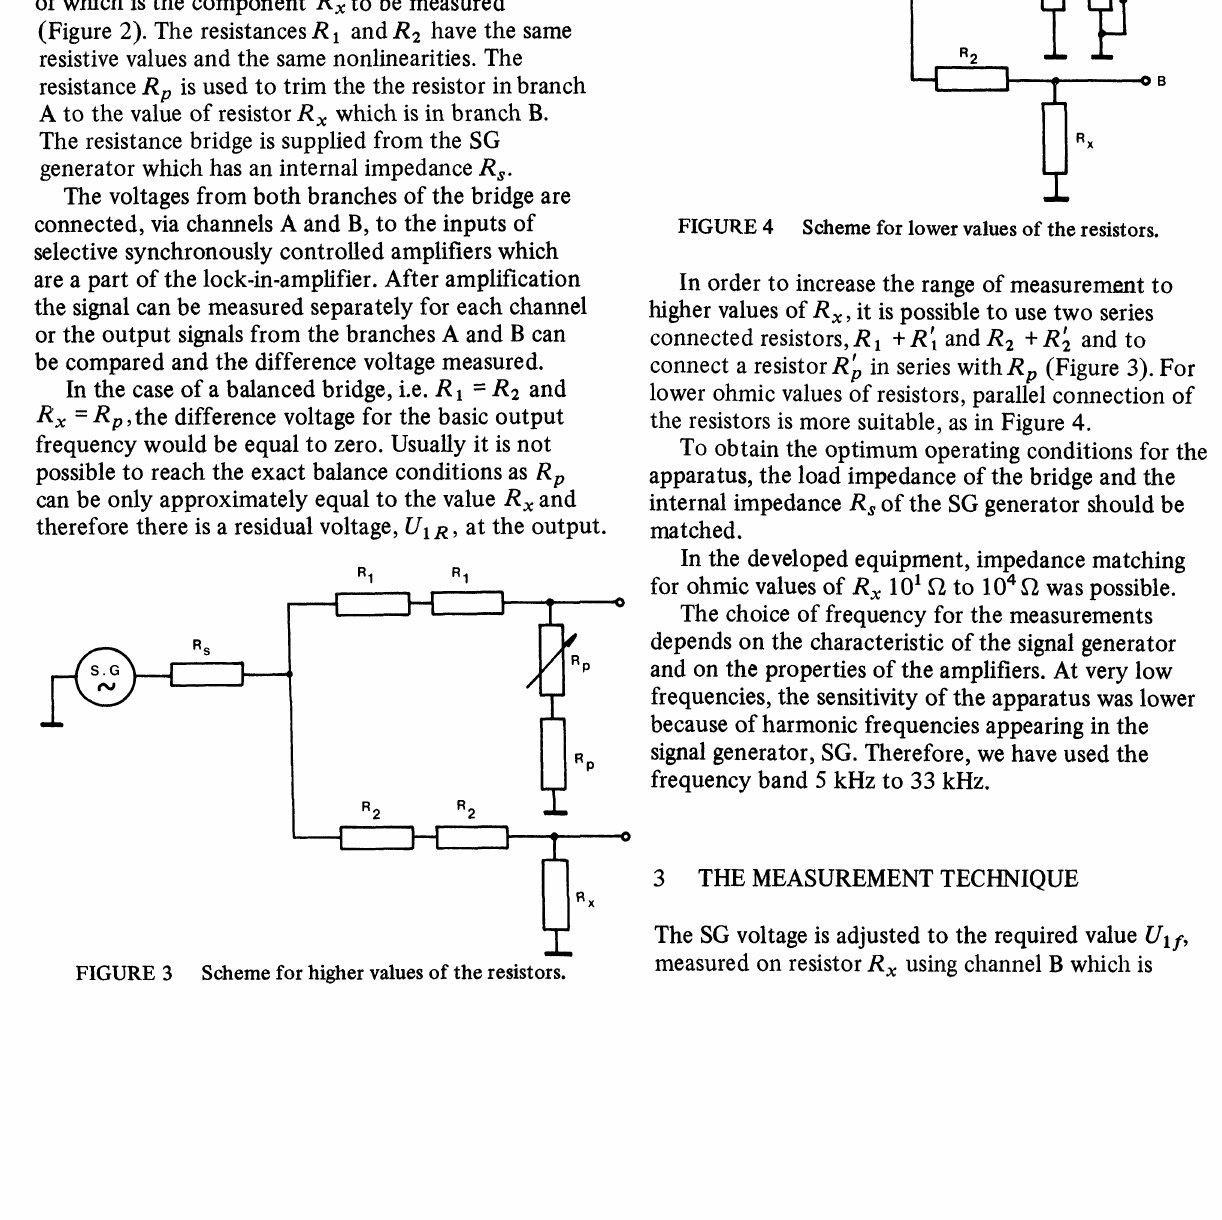
Scheme for higher values of the resistors.